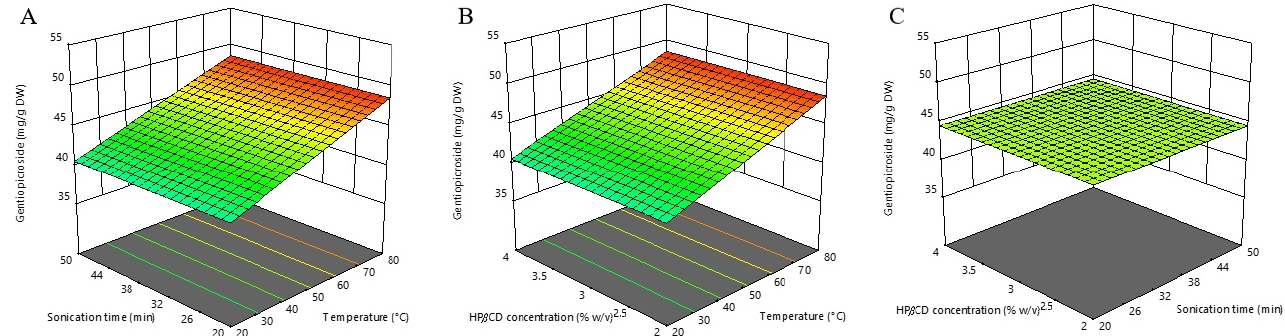
Figure 2. Three-dimensional response surfaces plots of gentiopicroside as a function of sonication time/temperature ( A ); hydroxypropyl- β -cyclodextrin (HP β CD) concentration/temperature ( B ); and HP β CD concentration/sonication time ( C